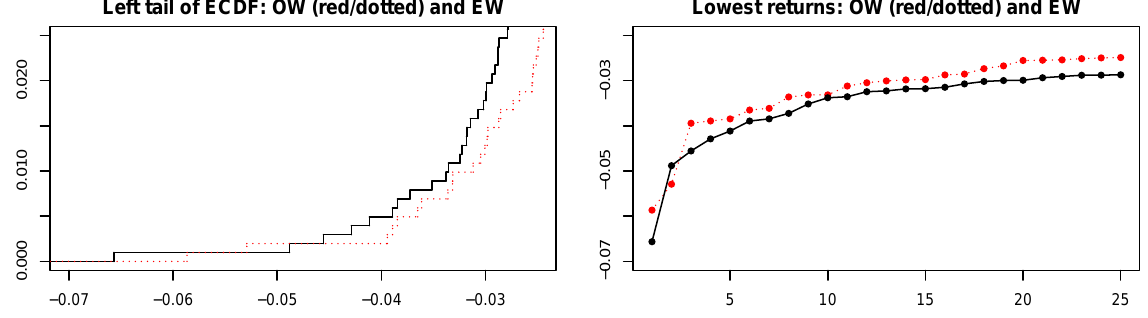
Figure 7. ( Left panel ): Left tails of the empirical cumulative distribution functions of the optimally weighted (OW) and equally weighted (EW) portfolios; OW in red/dotted and EW in black/solid. ( Right panel ): Lowest 2.5% of returns from the two portfolios; OW in red/dotted and EW in black/solid; the horizontal axis marks